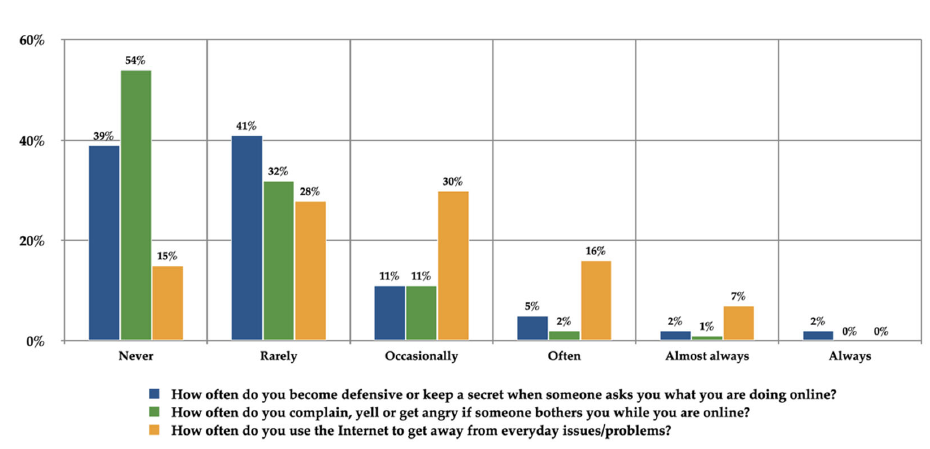
Figure 8. Attitudes towards time spent online.